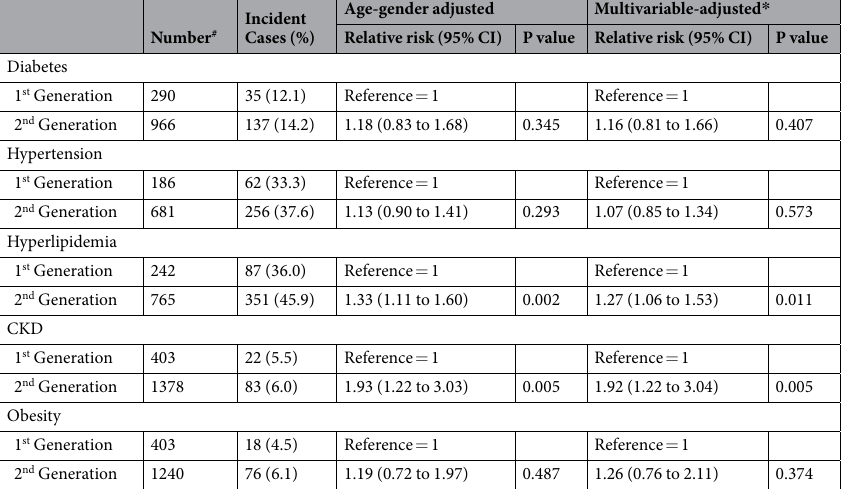
Table 1 shows the differences in baseline characteristics of participants by immigration status (first versus second-generation). Compared to first (n = 406, 23.2%), second-generation individuals (n = 1343, 76.8%) were younger, more likely to be female and to be obese, have low SES (primary or lower education, and individual monthly income < SGD2000), were smokers and have a longer duration of stay in Singapore. Table 2 shows the differences in baseline characteristics of participants who returned for follow-up versus those who did not. Compared to those who returned for follow-up (n = 1749, 67.2%), those lost to follow-up (n = 854, 32.8%) were older, more likely to be smokers, have low SES, have other comorbid conditions such as diabetes, hypertension, CKD and were more likely to be on antihypertensive medications.